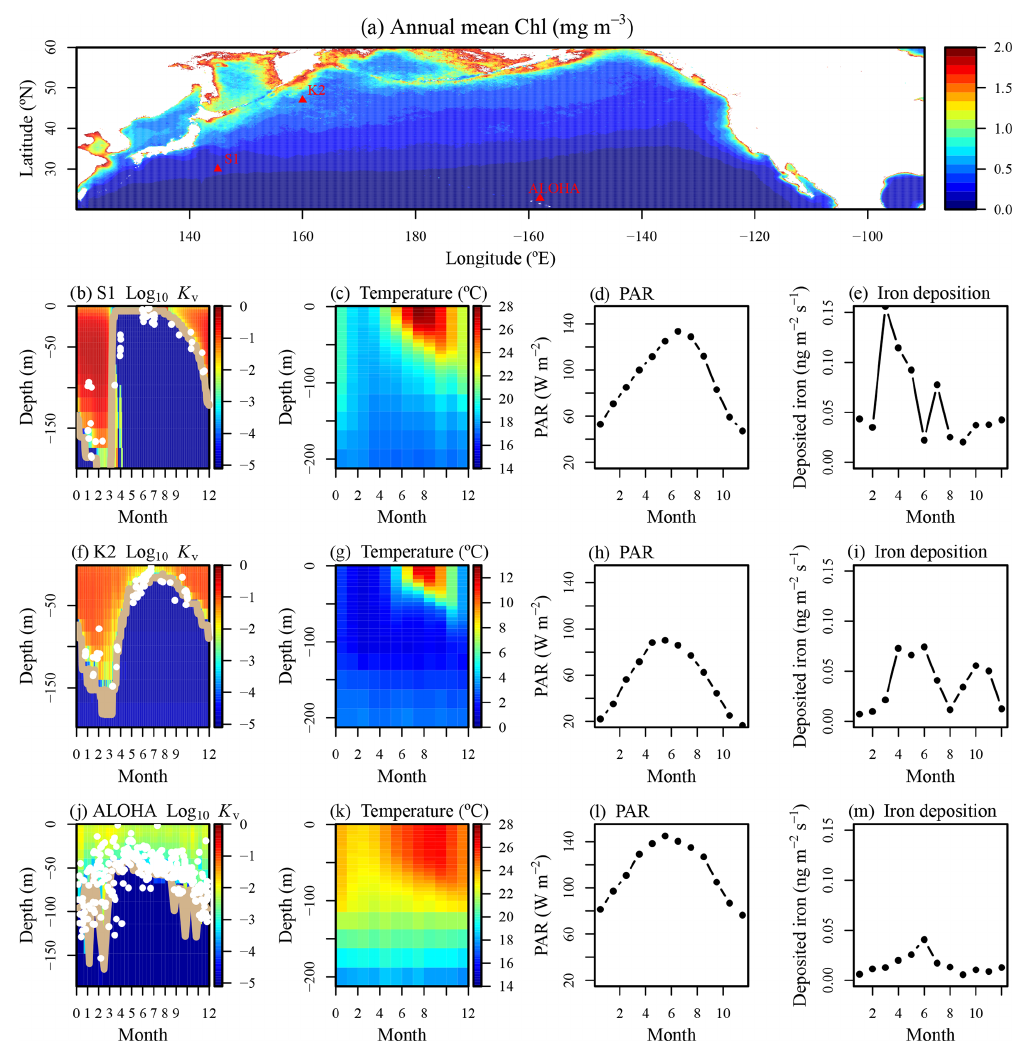
Figure 2. (a) Locations of the three stations K2, S1, and ALOHA overlaid on annual Chl a climatology of the North Pacific. (b)–(e) Seasonal forcing of vertical eddy diffusivity ( K v ) , temperature, surface PAR, and atmospheric dust deposition, respectively, at station S1. The white squares are measured mixed layer depths from in situ temperature and salinity profiles. The thick tan line represents mixed layer depths calculated from a threshold of 10 − 4 m 2 s − 1 . (f)–(i) The same as (b)–(e) , but for station K2. (j)–(m) The same as (b)–(e) , but for station